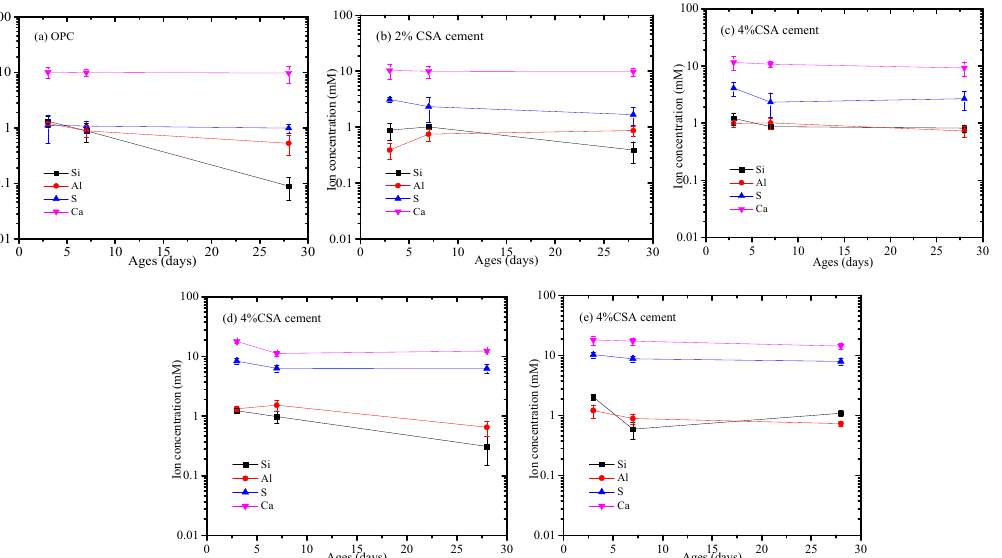
Figure 7. Elemental composition of pore solution for OPC and OPC/CSA blends, ( a ) OPC; ( b ) OPC-2%CSA cement; ( c ) OPC-4%CSA cement; ( d ) OPC-6%CSA cement; ( e ) OPC-8%CSA cement.